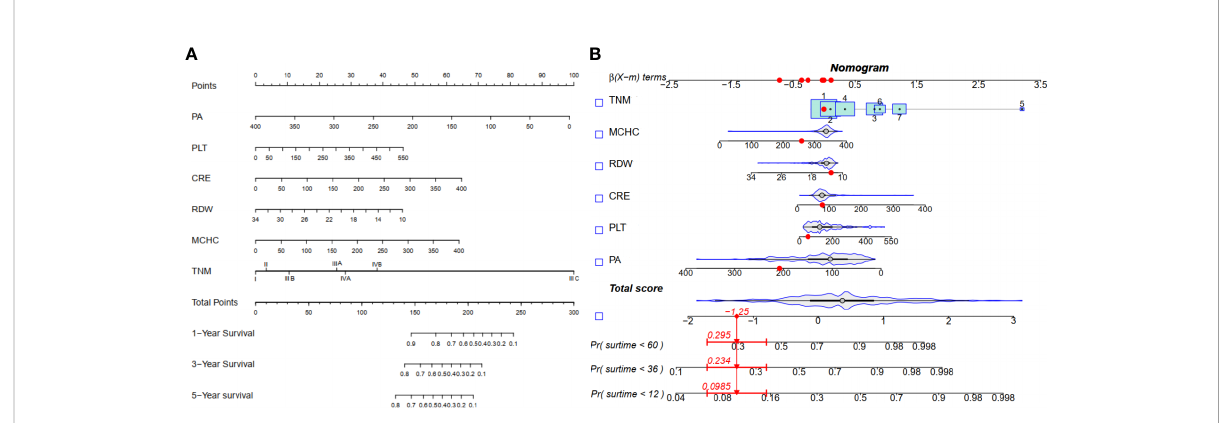
FIGURE 3 Nomogram for 1-, 3-, and 5-yearOS in alcohol related hepatocellular carcinoma patients. (A) Line segment static nomogram; (B) Line segment dynamic